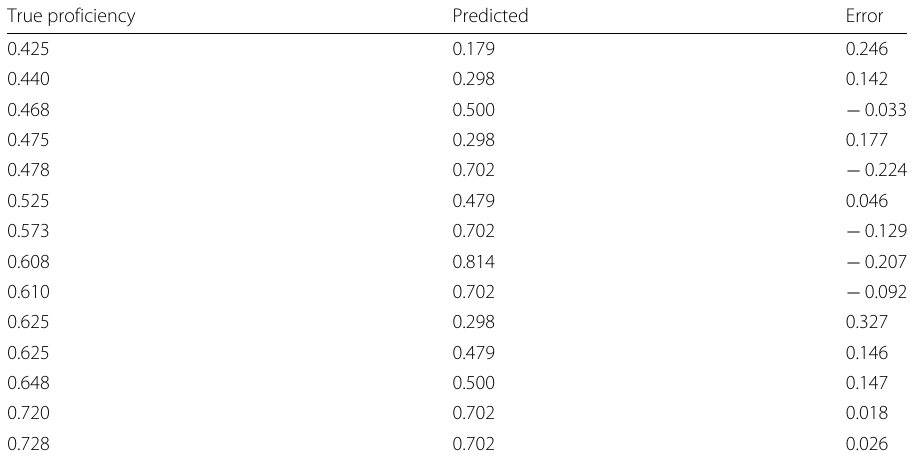
Table 9 Sample error values ( CAT_AVG simulation, class A)